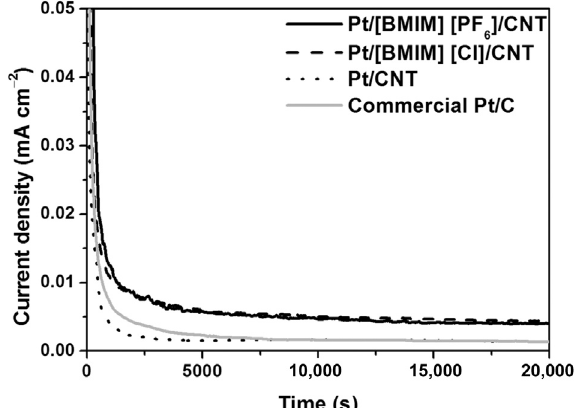
Figure 4 . Chronoamperometric curves of Pt/[BMIM][PF 6 ]/CNT, Pt/[BMIM][Cl]/CNT, Pt/CNT nanohybrids, and commercial Pt/C NPs electrodes at a fi xed potential of (cid:1) 0.1 V vs. Ag/AgCl in 0.5 M KOH containing 0.5 M